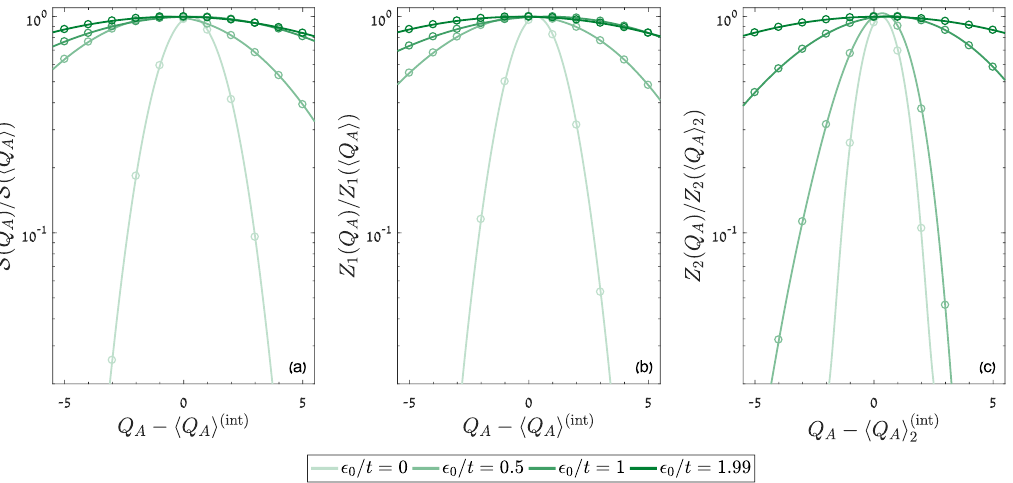
Figure 4: The single impurity model: Symmetry-resolved entanglement measures, calculated using Eqs. (19) and (20), where the generating function was evaluated analytically through Eq. (34) (lines) and numerically through Eqs. (17) and (21) (circles), in a subsystem of L = 20000 sites. Results are shown as a function of Q , A / t , with k = π/ 2 and the charge in subsystem A , for various fixed values of ε F , R 0 − k = 0.1. The charge Q k is measured relative to the rounded mean charge F , L F , R A 〈 Q 〉 ( int ) defined in Eq. (54), and the results are normalized by the analytical value A n 〉 exactly at 〈 Q . Panels (a) and (b) show the resolved vNEE and first Rényi moment, A n 〉 = 〈 Q 〉 respectively, for which we set n = 1 (with 〈 Q ), whereas panel (c) shows A A n = 1 the resolved second Rényi moment, where we use n =